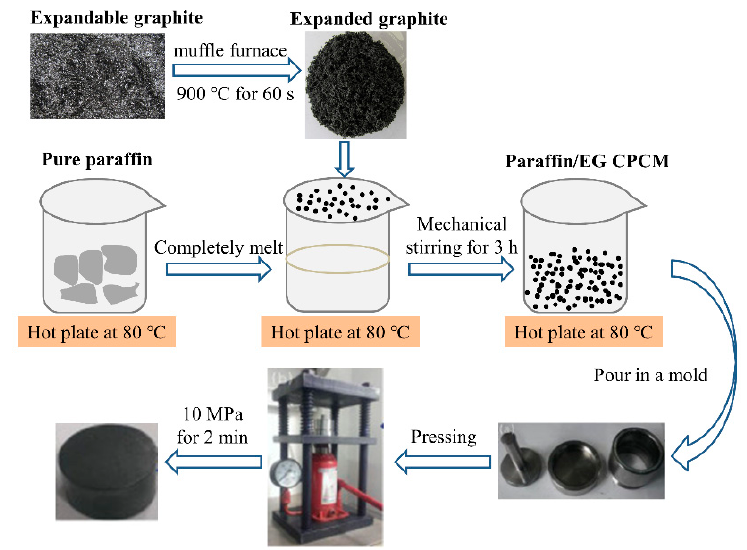
Figure 2. The fabrication process of the formable paraffin/EG CPCM.